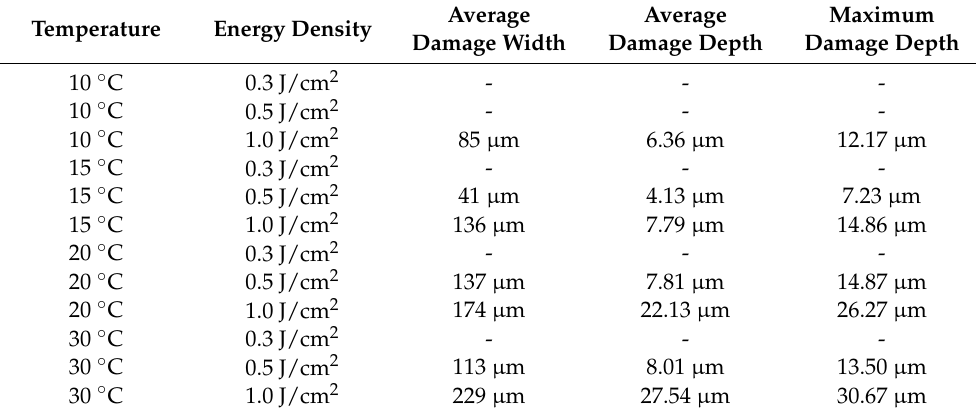
Table 10. Width and depth of laser damage pit of temperature group.